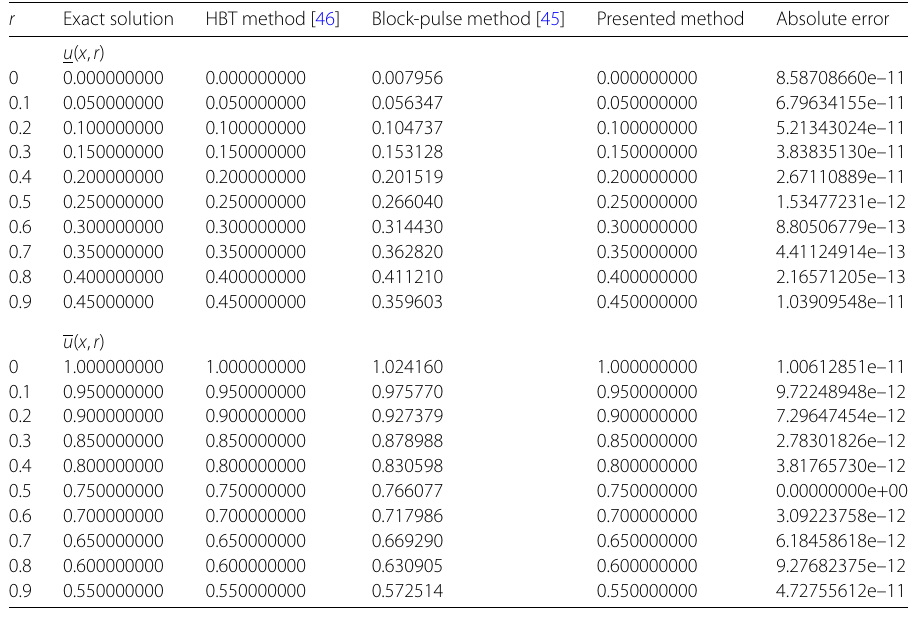
Table 1 The numerical results for Example 1 with x = 0.5, M = 2, N =